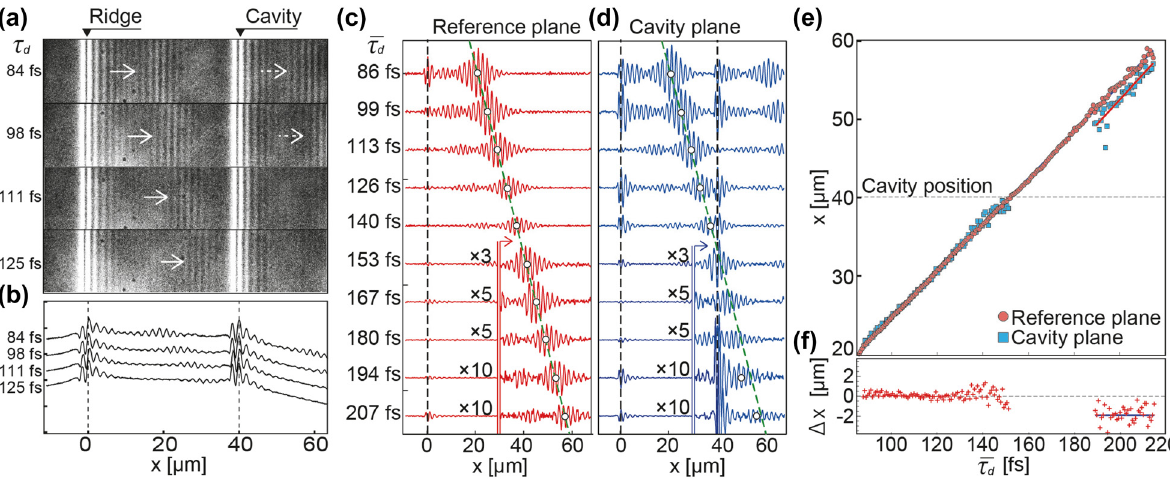
Figure 3: Sequences of time-resolved fluorescence images of SPP WP. (a) Selected frames of time-resolved two-photon fluorescence movie. Thecrosssectionsofthebeatpatternsin(a)werepreparedbyaddition-averagingtheimagesalongthe y directionandareshownin(b).Cross sectionsof time-resolved differential micrographs taken from (c) reference plane and (d)cavity plane containing MIM-NCwith L = 160 nm.The range of the delay time was τ d = 86 – 207 fs with an interval of 13.5 fs or 5 × 2 π rad of the carrier wave of the excitation laser. The open circles indicatethecoordinatesoftheintensitymaximaofthebeatpatterns.Thegreendottedlinein(c),indicatingaconstantadvancementofanSPP WP,isduplicatedandplottedin(d).(e)Coordinatesofintensitypeaksofbeatpatternstakenfromreferenceplane(redcircles)andcavityplane (blue squares) plotted as function of average delay time. The intensity maxima in the cavity plane exhibited a homogeneous negative shift compared to those in the reference plane over the region where isolated WP forms were recovered ( x ≥ 50 μ m). The amounts of shifts ( Δ x ) are shown in (f). The exposure times for microscopy images ranged from 5 to 40 s depending on the delay time. The intensity of each image was normalized by the exposure